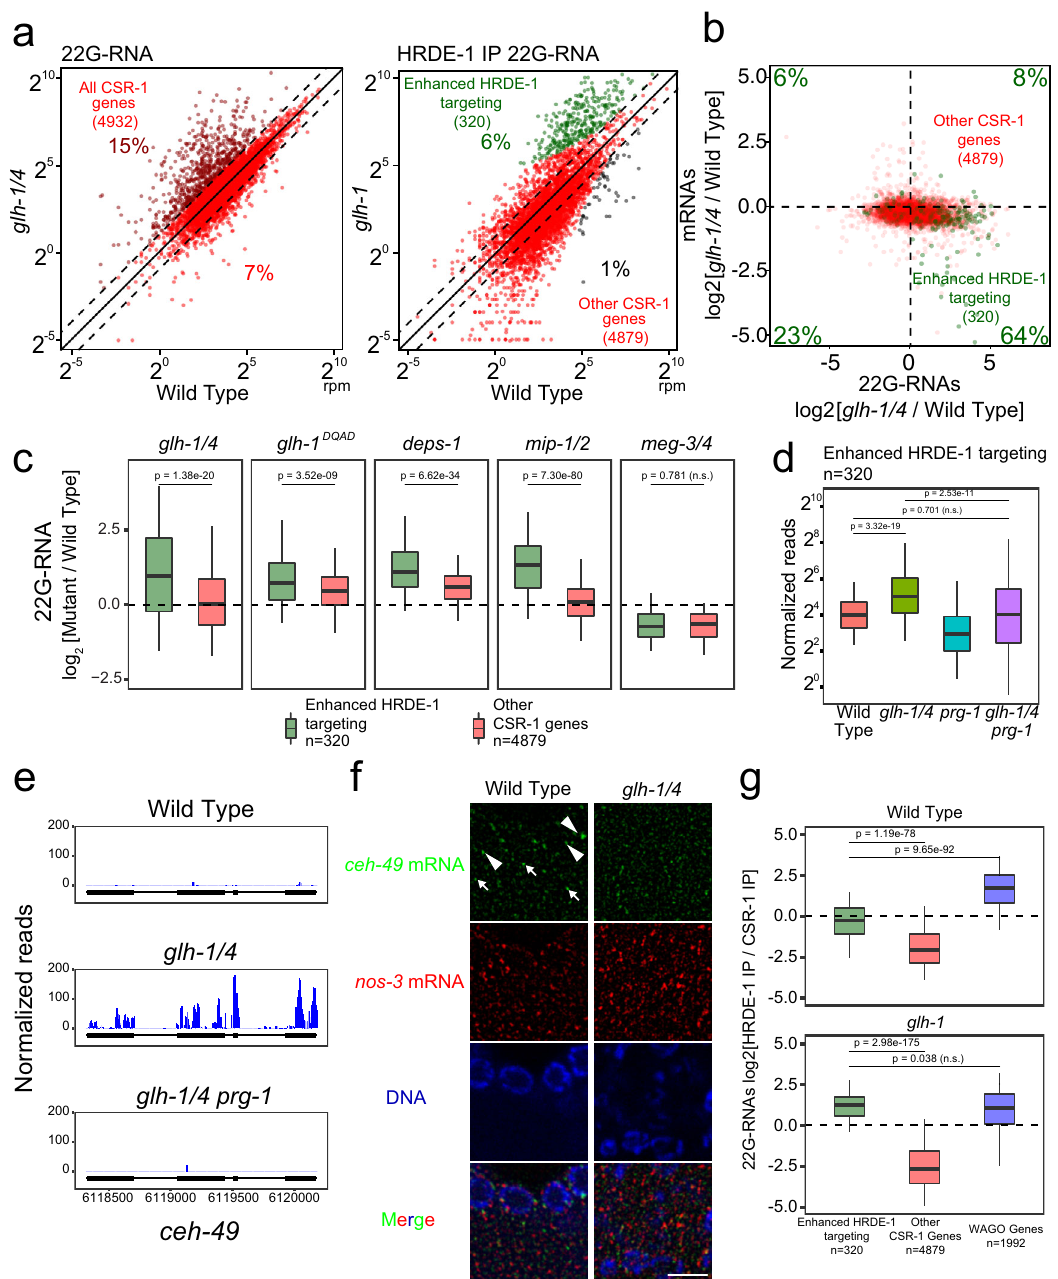
Fig. 5 | Many functionalgermlinegenes aresilencedin mutantswithdefectsin forming perinuclear PRG-1 granules. a A scatter plot showing the abundance of all22G-RNAs(left)orHRDE-1bound22G-RNAs(right)mappedtoeachCSR-1target in wild-type worms compared to indicated strains. (Left) Percentages of CSR-1 targets with twofold increased or decreased 22G-RNAs in mutants are shown. (Right)Thepercentageofsigni fi cantlychanged(adjusted P <0.05[seeMethodsfor details] and twofold) CSR-1 targets are shown. Diagonal lines indicate a two-fold increase(top),nochange(middle),oratwofolddepletion(bottom)intheindicated mutantstrains. b AscatterplotshowingthemRNAvs22G-RNAexpressionchanges for CSR-1 targets in the indicated strain. Percentages in each quadrant indicate the proportion of CSR-1 targets with enhanced HRDE-1 targeting that fall in that quadrant. c 22G-RNA fold changes for CSR-1 targets with enhanced HRDE-1 tar- getingversusallotherCSR-1targetsintheindicatedstrainsversuswild-typeworms. Statisticalanalysiswasperformedusingatwo-tailedMann – WhitneyWilcoxontest. Forallboxplots,linesdisplaymedianvalues,boxesdisplay fi rstand thirdquartiles, and whiskers display 5th and 95th percentiles. d 22G-RNA accumulation for CSR-1